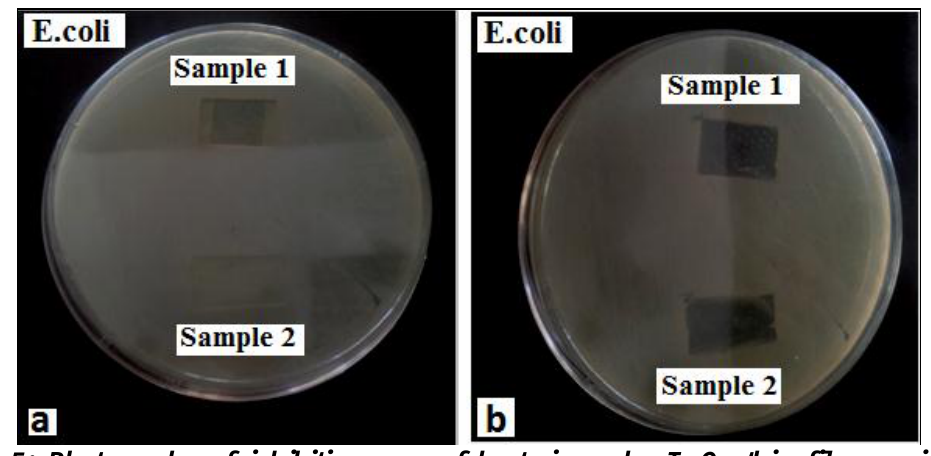
Fig. 5: Photography of inhibition zone of bacteria under In Escherichia coli (E.coli) a) when the bottom of In under the bottom of In Table 2: Inhibition Zones diameters in (cm) of In